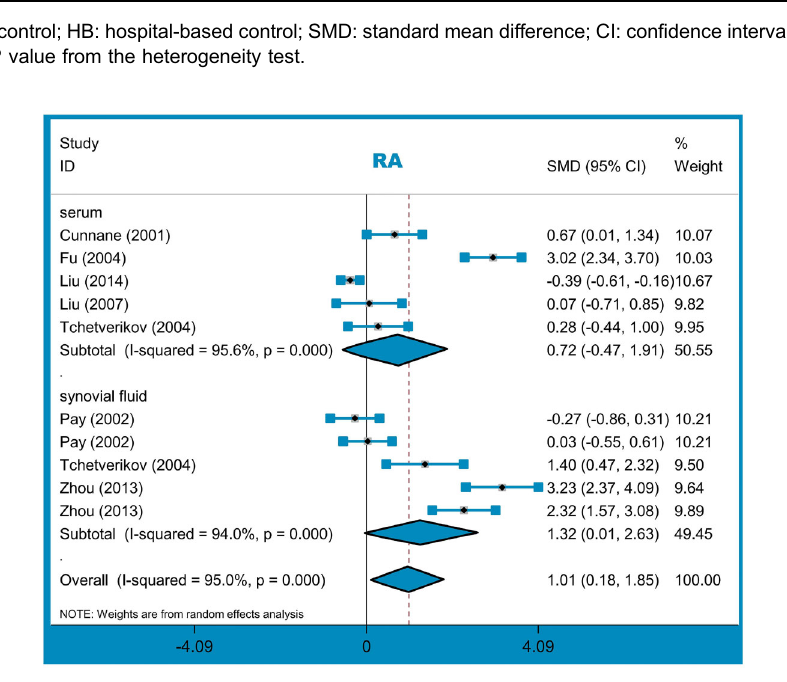
Figure 2. Subgroup analysis by sample source for rheumatoid arthritis (RA) risk. See Supplementary Table S1 for reference numbers.